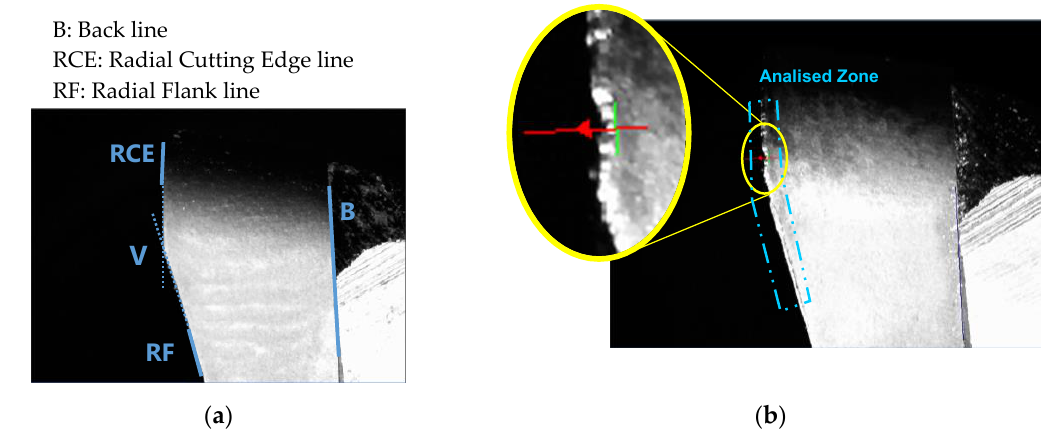
Figure 11. ( a ) References to radial flank images. ( b ) Zone of tool wear measurement.